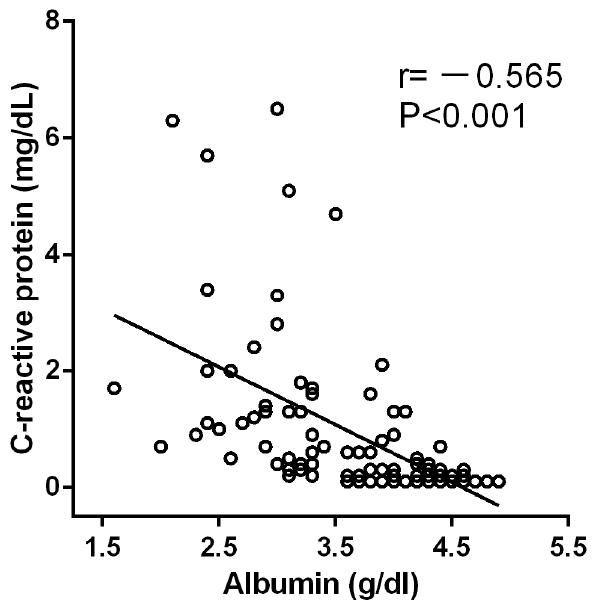
Figure 1. The correlation between albumin and CRP.